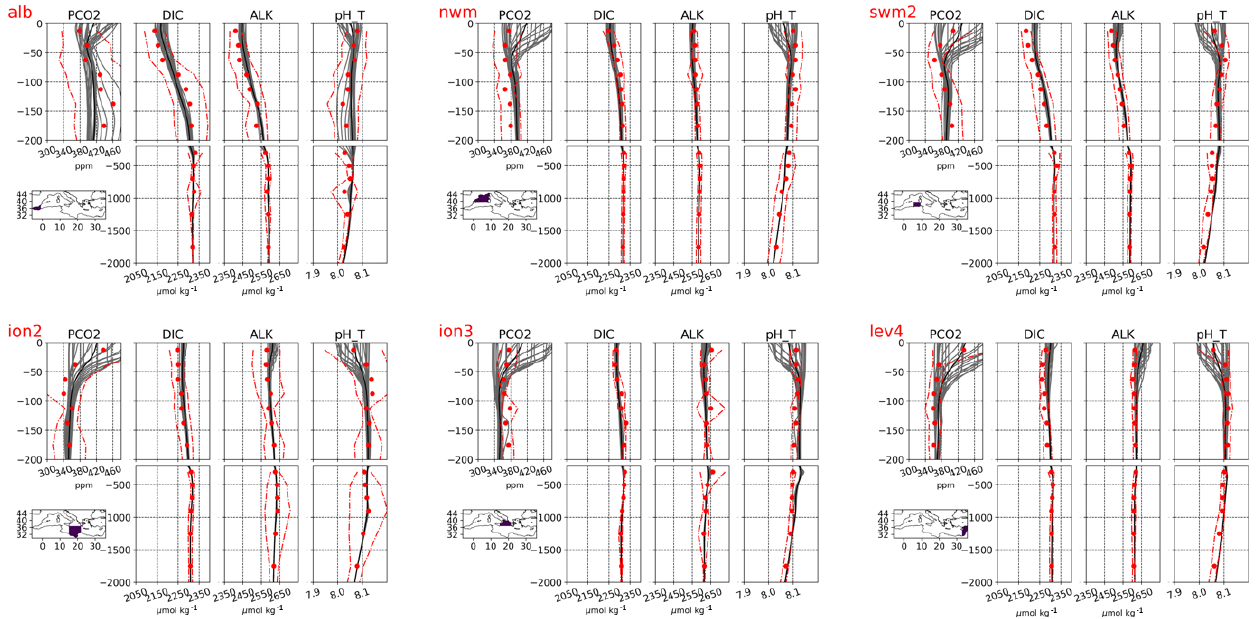
Figure 6. Monthly (grey lines) and mean (black lines) vertical profiles from the qualification run for selected sub-basins of Fig. 2 compared with climatological profiles (red dots) and variability ranges (one standard deviation, red lines) of dissolved inorganic carbon (DIC), alka- linity (ALK), pH in total scale and in situ condition (pH_T), and carbon dioxide partial pressure ( p CO 2 ). Climatological data for pH_T and p CO 2 are reconstructed using CO2Sys software (Lewis and Wallace, 1998).